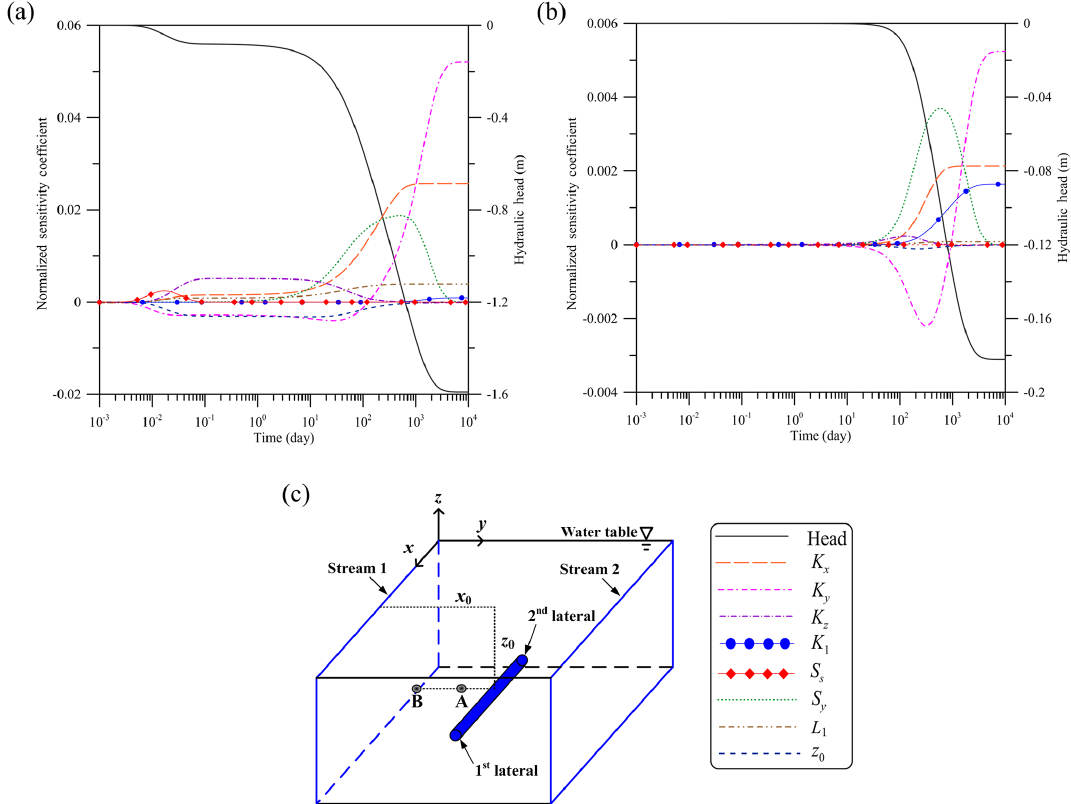
Figure 4. Temporal distribution curves of the normalized sensitivity coefficients for parameters K x , K y , K z , S s , S y , K 1 , L 1 , and z 0 observed at piezometers (a) A of (400, 340, − 10m) and (b) B of (400, 80, −